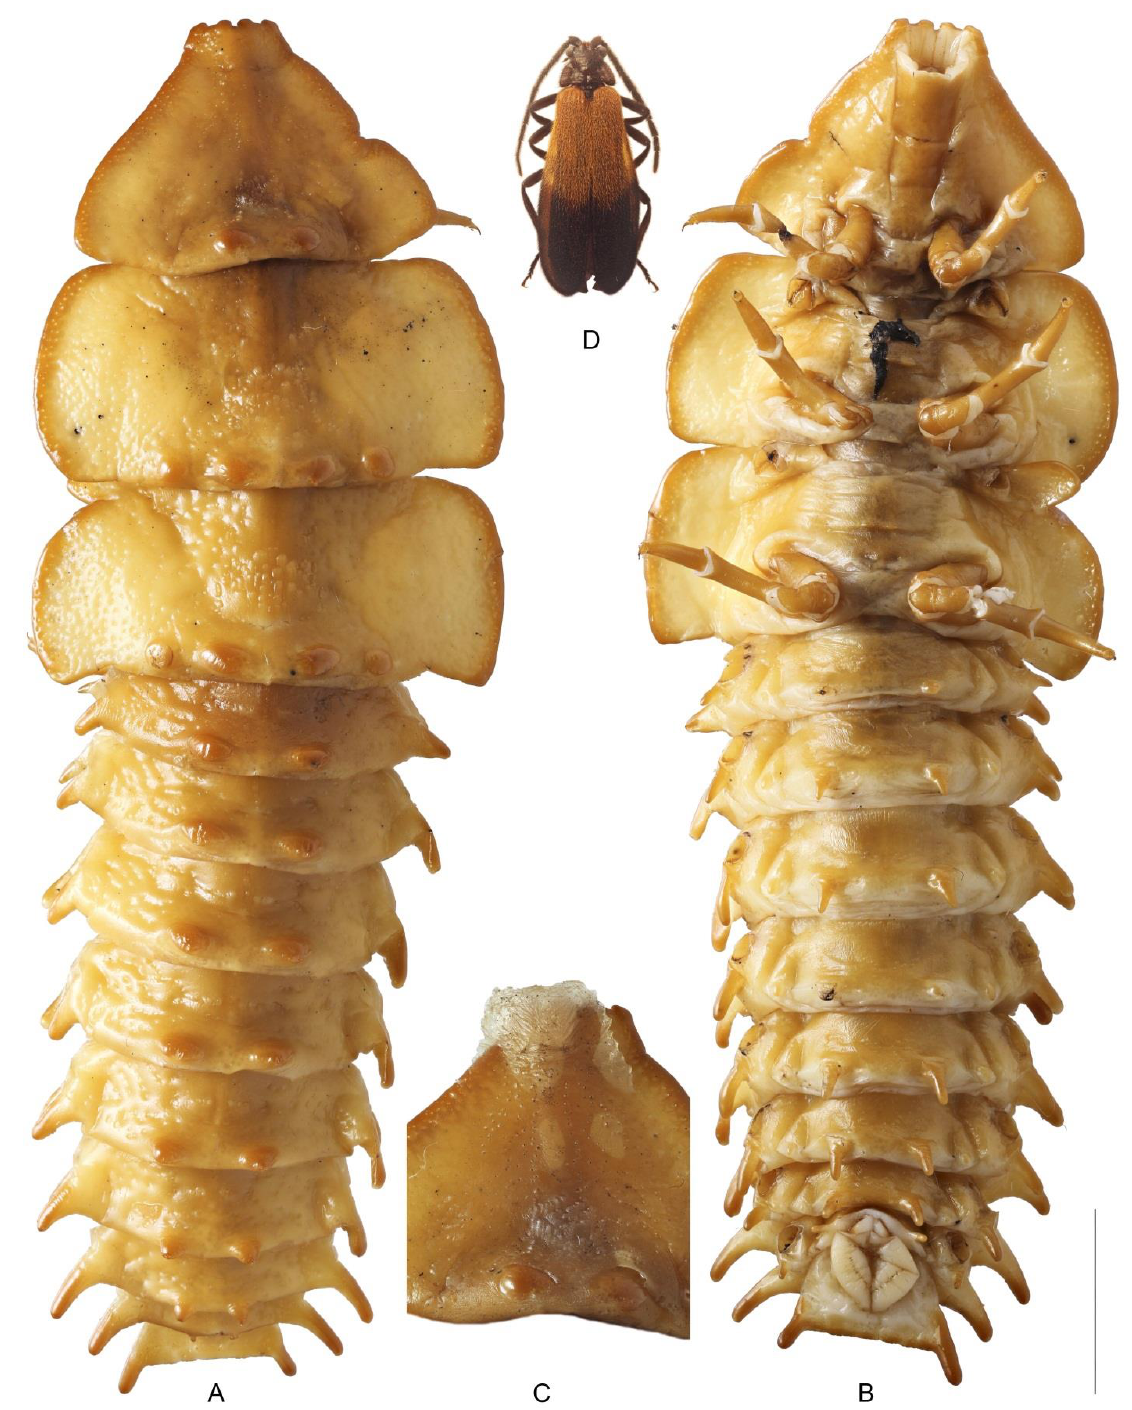
Figure 5. Platerodrilus svetae . ( A ) — female, general view, dorsally; ( B ) — same, ventrally; ( C ) — same, part of pronotum dorsally, showing two layers of cuticle; ( D ) — male (length: 9 mm). Scale bar — 5 mm.